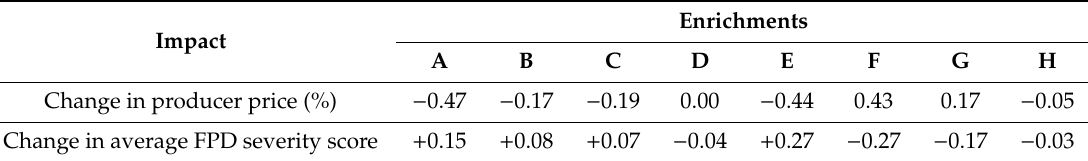
Table 4. Percent change in the average producer price resulting from the average changes to FPD score in each enrichment group compared to the